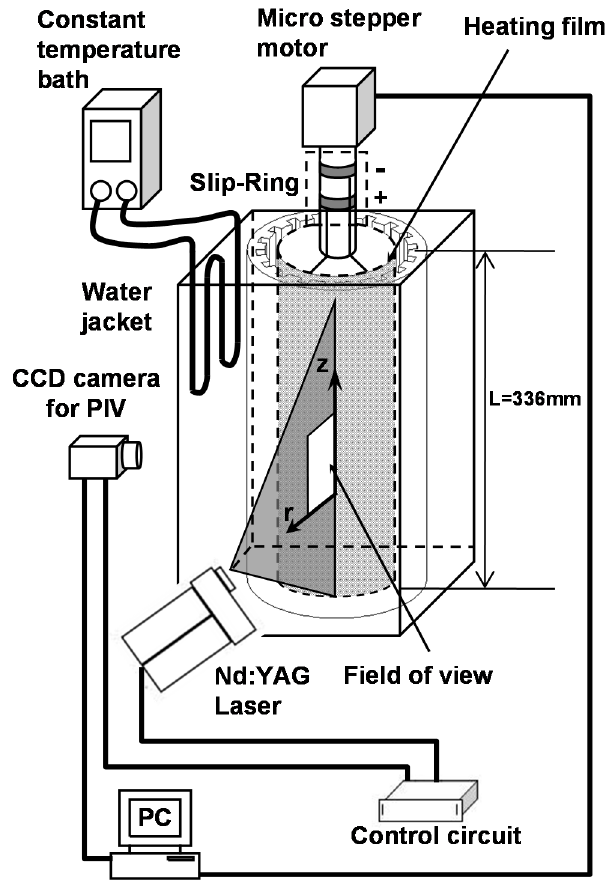
Figure 1. Schematic diagram of the experimental